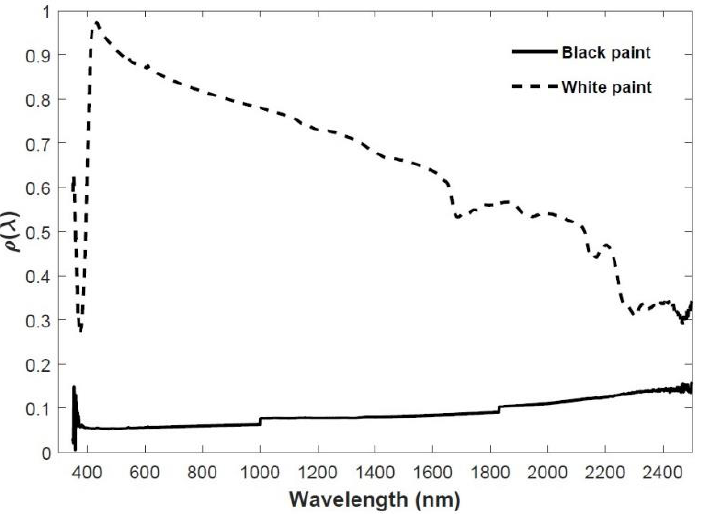
Figure 2. Spectral reflectivity [ ρ(λ) ] of the white and black paints used to construct the discs.